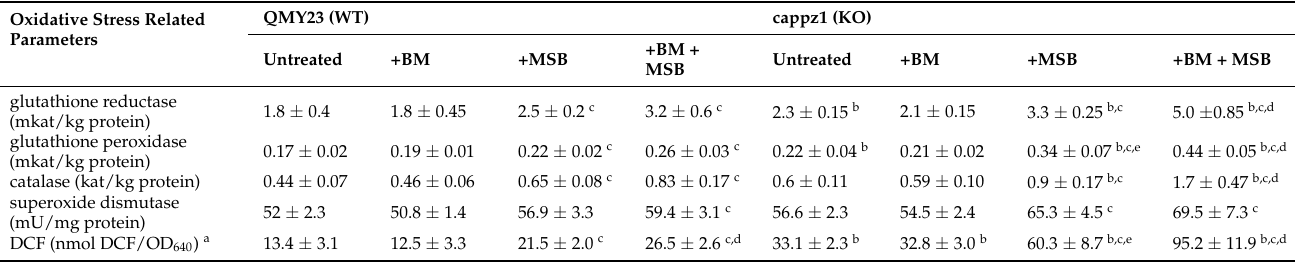
Table 4. Betamethasone (BM) or/and menadione sodium bisulfite (MSB) induced changes in the antioxidant enzyme activities and redox homeostasis of C. albicans